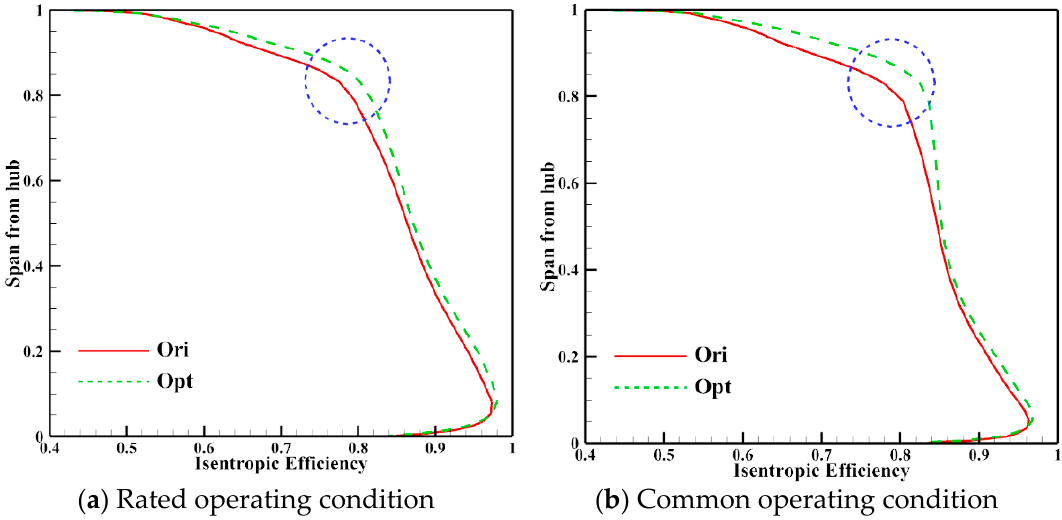
Figure 15. Span ‐ wise isentropic efficiency. Figure 15. Span-wise isentropic efficiency.